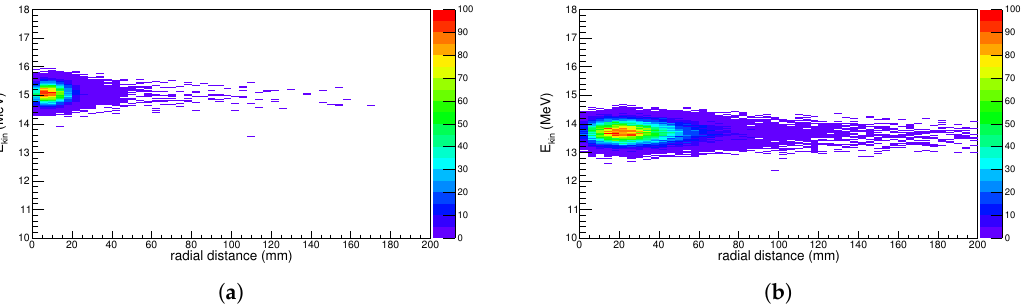
Figure 8. Example of simulated kinetic energy profile off-axis as a function of the radial distance, integrated over all directions contained in the scoring plane. The kinetic energy of the protons impinging on the active layer of the film is plotted against the distance of their interaction point from the beam axis in the transverse plane. Both plots represented here have been obtained for a distance between the exit window and the film of 63cm, without ( a ) and with ( b ) a 50 µ m tungsten scattering foil.